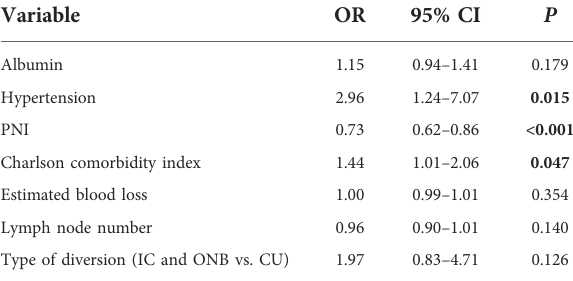
TABLE 4 Multivariate analysis of overall postoperative complications after RARC.